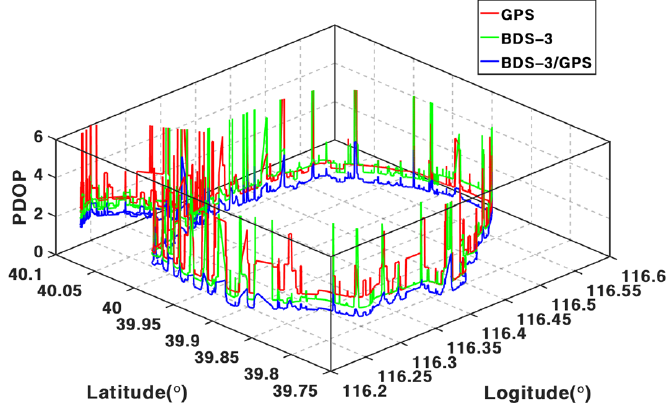
Figure 2. The available satellites number of different GNSS along with the test trajectory.